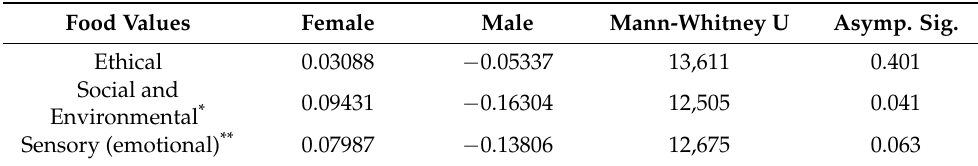
Table 8. Perception of underlying dimensions by gender. Food Values